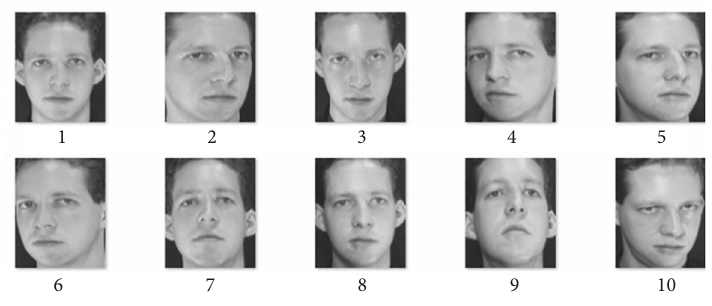
Figure 2: Sample of ORL face image. Table 1: The comparison of the recognition rate between the 2DPCA algorithm and this algorithm under different principal components in the ORL Library (%).